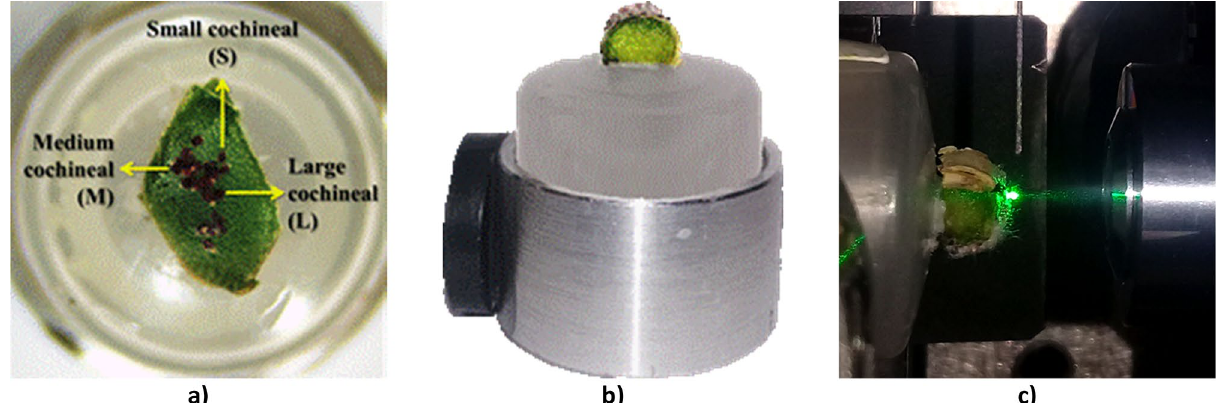
Figure 9. Sample. ( a ) Top view of the biological sample composed by a portion of cladode with presence of female cochineals classified in sizes S, M and L, indicated by yellow arrows. ( b ) Homemade sample-holder for the in-vivo measurement of fluorescence spectra from cochineals in their natural habitat, composed by a cylindrical plastic base where the biological sample is adhered on its top surface and an aluminum ring with two disk-shaped magnets for immobilization purposes. ( c ) Picture taken during the in-vivo fluorescence study of the cochineals in their natural habitat, when the cladode portion with the cochineals in nymph I and II stages is fitted on the sample-holder of the experimental